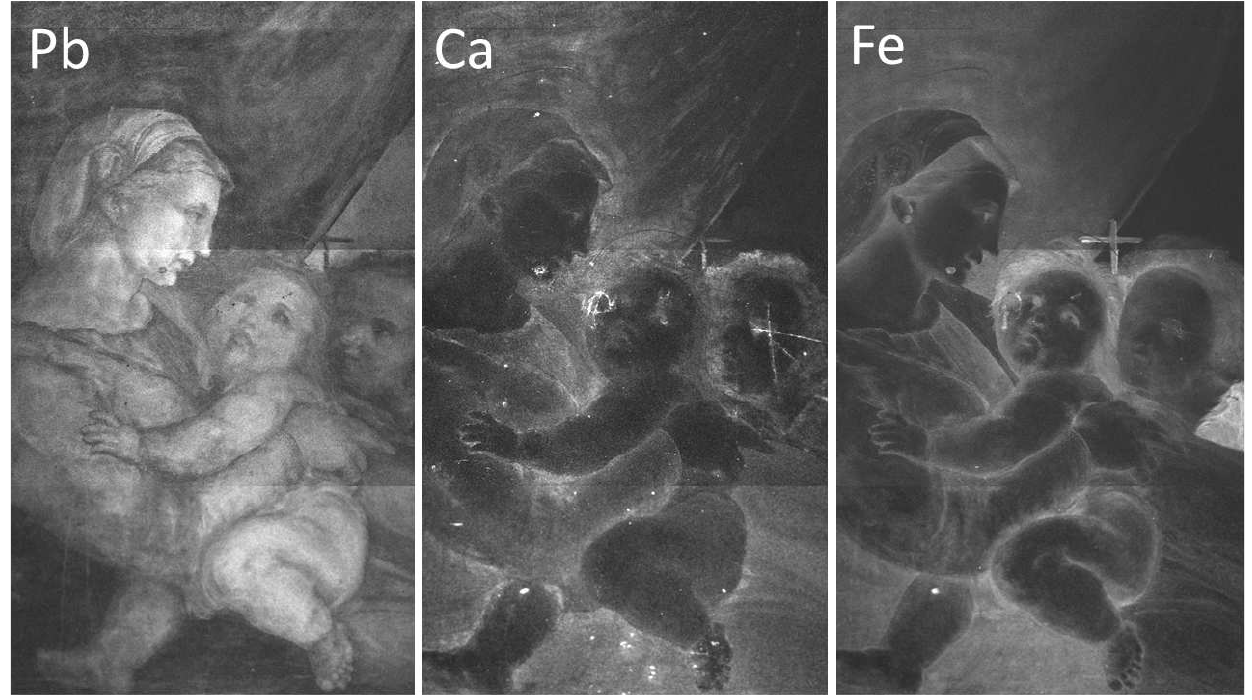
Figure 10. MA-XRF distribution maps of lead, calcium, and iron.